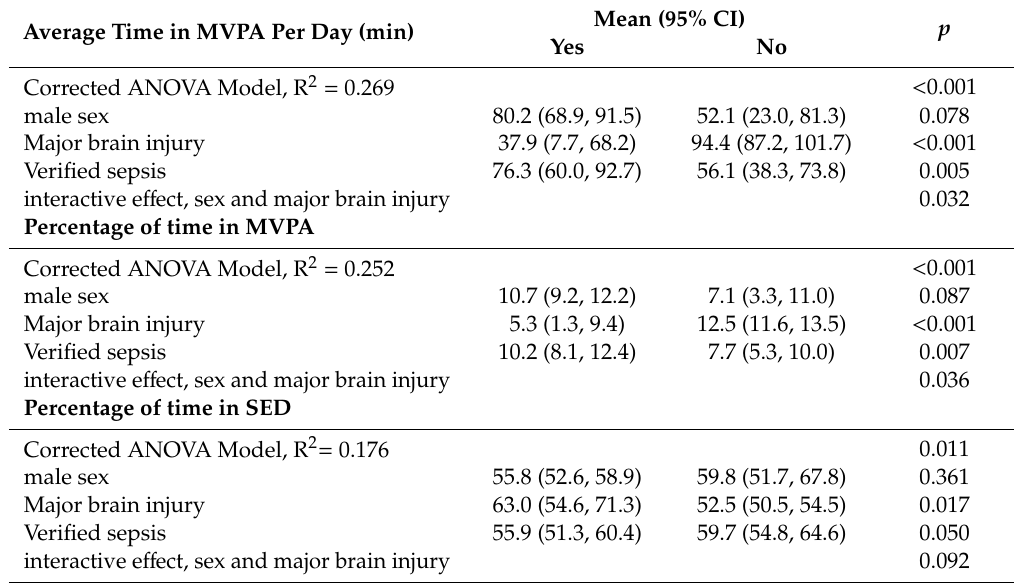
Table 3. Correlations of birth characteristics and perinatal morbidities to